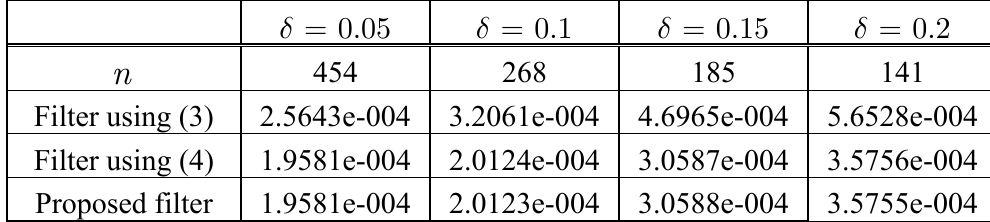
Table 1. Estimation error with different δ values in case 1.